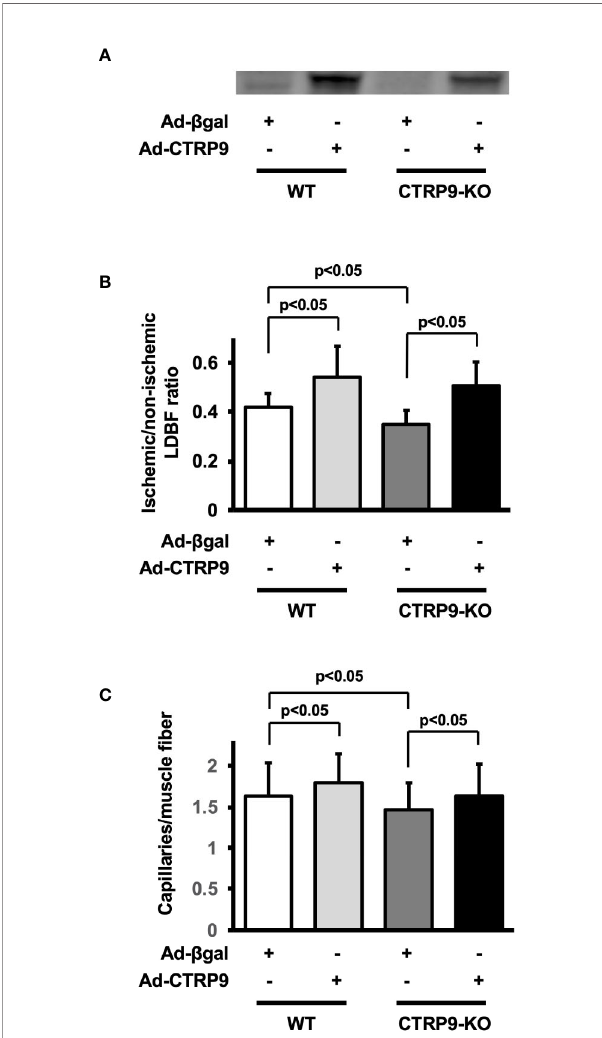
FIGURE 2 | CTRP9 supplementation enhances perfusion of ischemic limbs in WT and CTRP9-KO mice. (A) CTRP9 expression in plasma in WT and CTRP9-KO mice after treatment with Ad-CTRP9 or Ad- b -gal (control). Ad- CTRP9 or Ad- b -gal was injected into the jugular vein of WT and CTRP9-KO mice (7 × 10 8 ifu in each group) at day 5 before surgery. Plasma CTRP9 levels were assessed at day 5 after adenoviral vector injection by Western blot analysis. (B) Quantitative analysis of ischemic to nonischemic laser Doppler blood fl ow (LDBF) ratio in WT and CTRP9-KO mice receiving Ad- b - gal or Ad-CTRP9 on postoperative day 14 (n = 4 – 9 mice for each group). (C) Quantitative analysis of capillary density in WT and CTRP9-KO mice receiving Ad- b -gal or Ad-CTRP9. Capillary density was expressed as the number of capillaries per muscle fi ber. Results are presented as mean ± SD (n = 3 mice for each group).